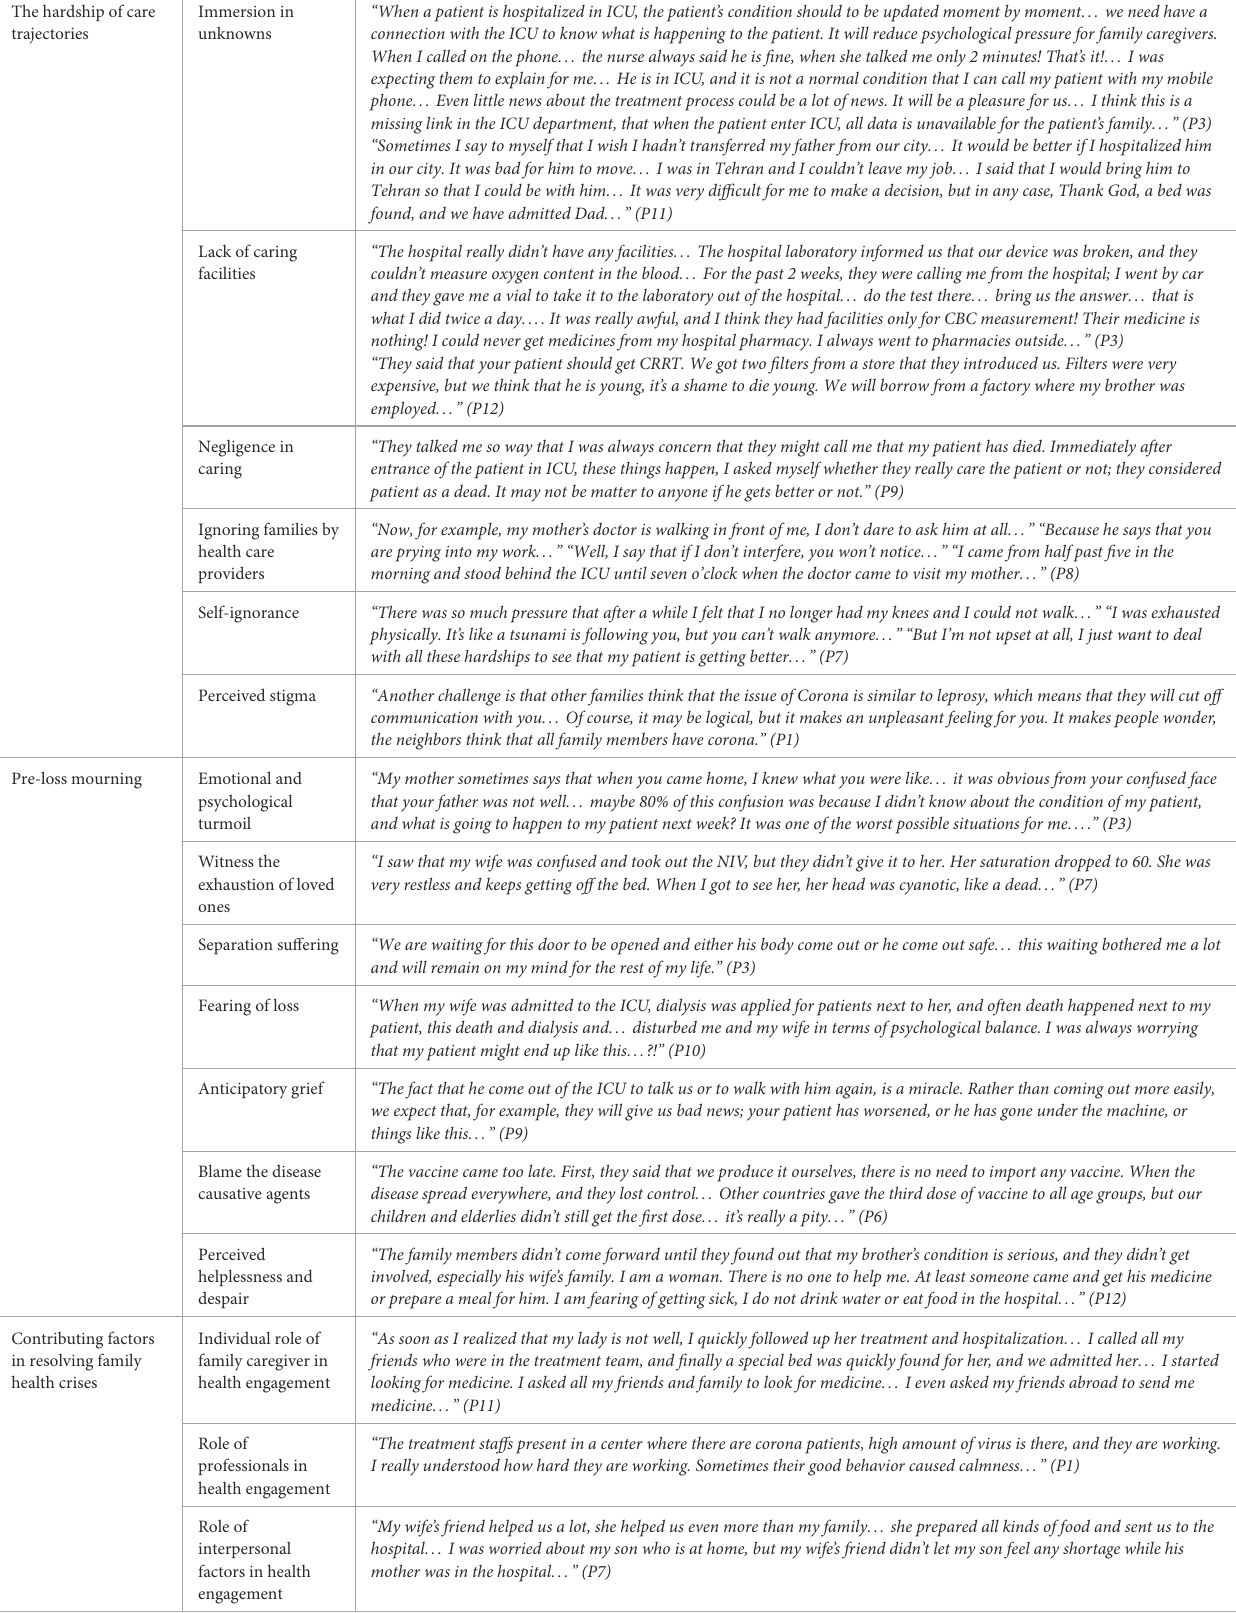
TABLE 3 Categories, sub-categories, and some quotes of the participants.